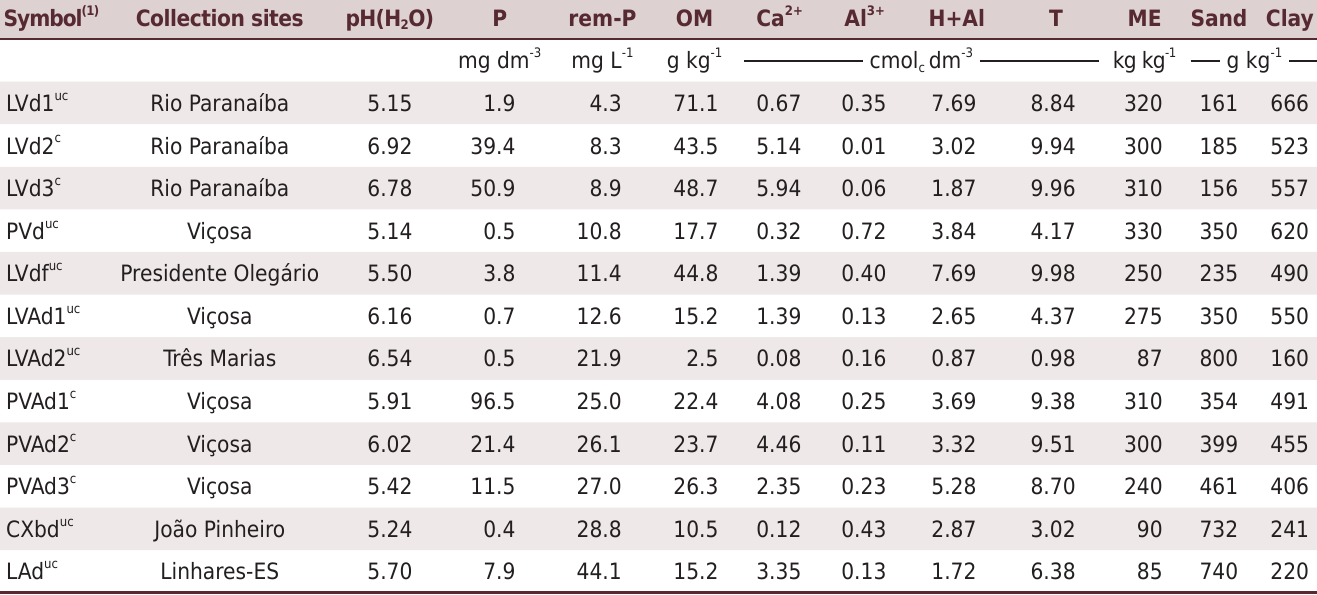
Table 1. Collection sites, physical and chemical characterization of soil samples Symbol